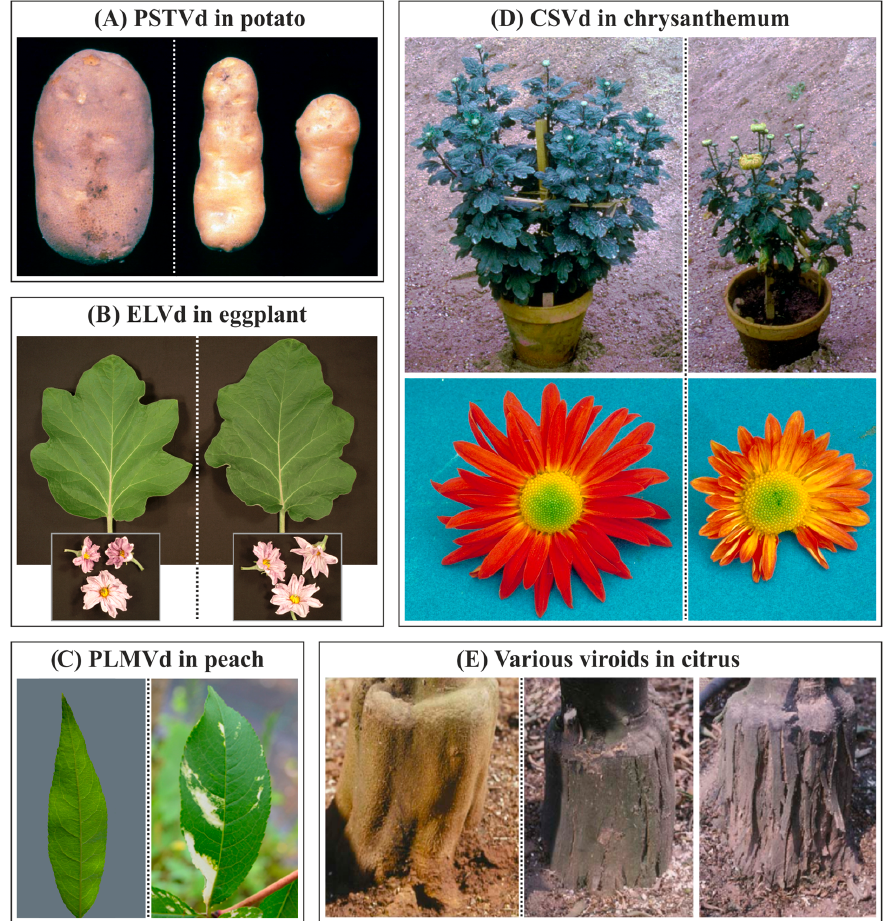
Figure 4. Typical symptoms of viroid infection in various crops. In all cases, mock-inoculated or symptomless plants are on the left, and viroid-infected plants are in the center and/or on the right. ( A ) PSTVd induces potato tuber malformations (image modified from original credited to William M. Brown Jr., Bugwood.org, accessed on 16 January 2023). ( B ) Symptomless infections induced by ELVd in eggplant (cv. Black Beauty). ( C ) Peach calico-inducing variants of PLMVd induce severe chlorosis in peach leaves (left image adapted from https://doi.org/10.3389/fpls.2012.00288, accessed on 16 January 2023; right image modified from original credited to H.J. Larsen, Bugwood.org). ( D ) CSVd infection induces stunting and earlier blooming in chrysanthemum (top), resulting in flower breaking and deformation (bottom) (top image modified from original credited to J. Dunez, Bugwood.org, accessed on 16 January 2023; bottom image modified from original credited to European and Mediterranean Plant Protection Organization, Bugwood.org, accessed on 16 January 2023. ( E ) Co-inoculation of citrus trees with CBLVd and CDVd induces symptomless infections in trees (left), while co-inoculation of CEVd and CBCVd induces bark scaling characteristic of CEVd infection (center) or severe bark cracking characteristic of CBCVd infection (right). Parts of this figures have been adapted from